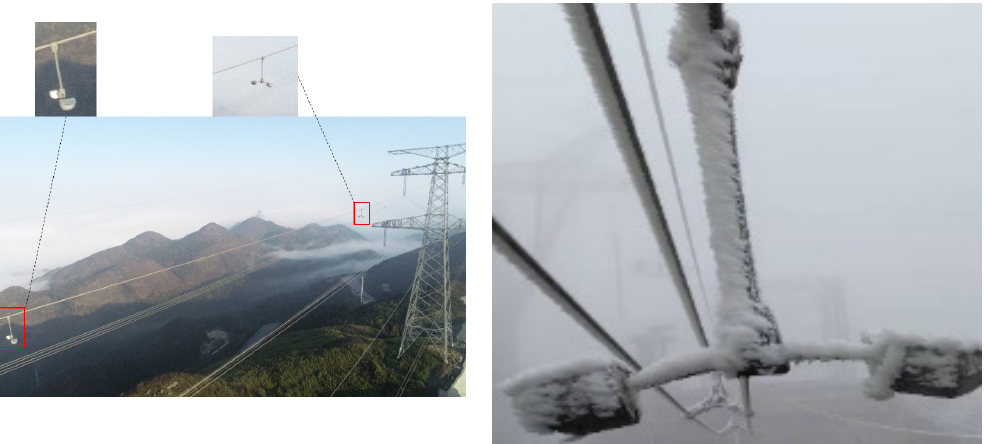
Figure 10. Application of torque pendulum.